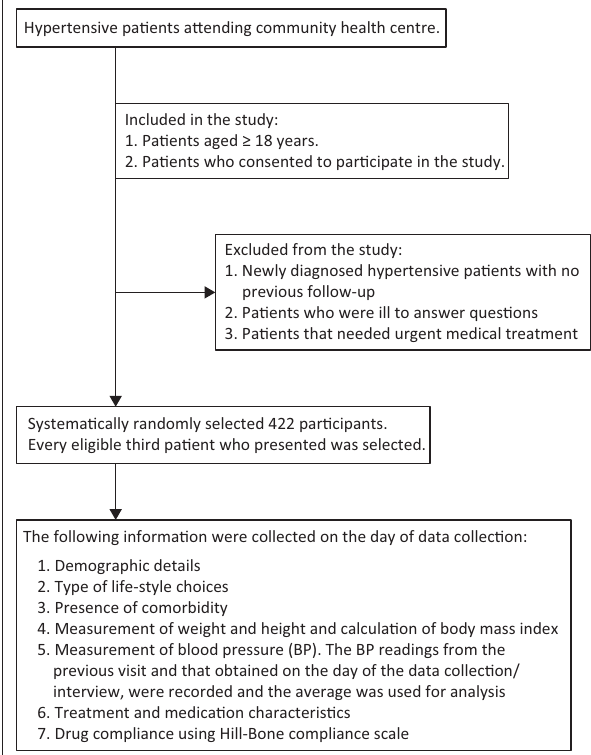
FIGURE 1: Flow diagram showing study participants and data collection.